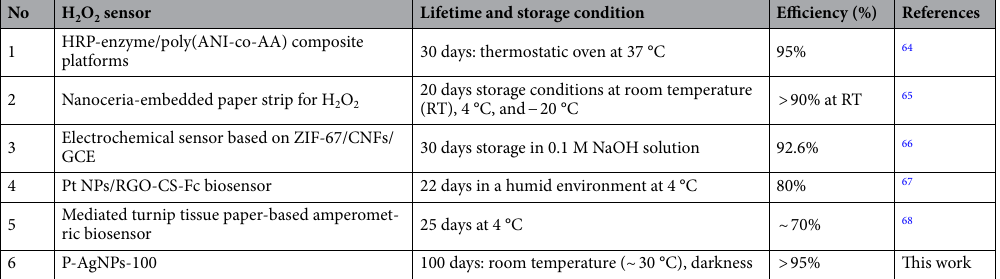
No H 2 O 2 sensor Lifetime and storage condition Efficiency (%)